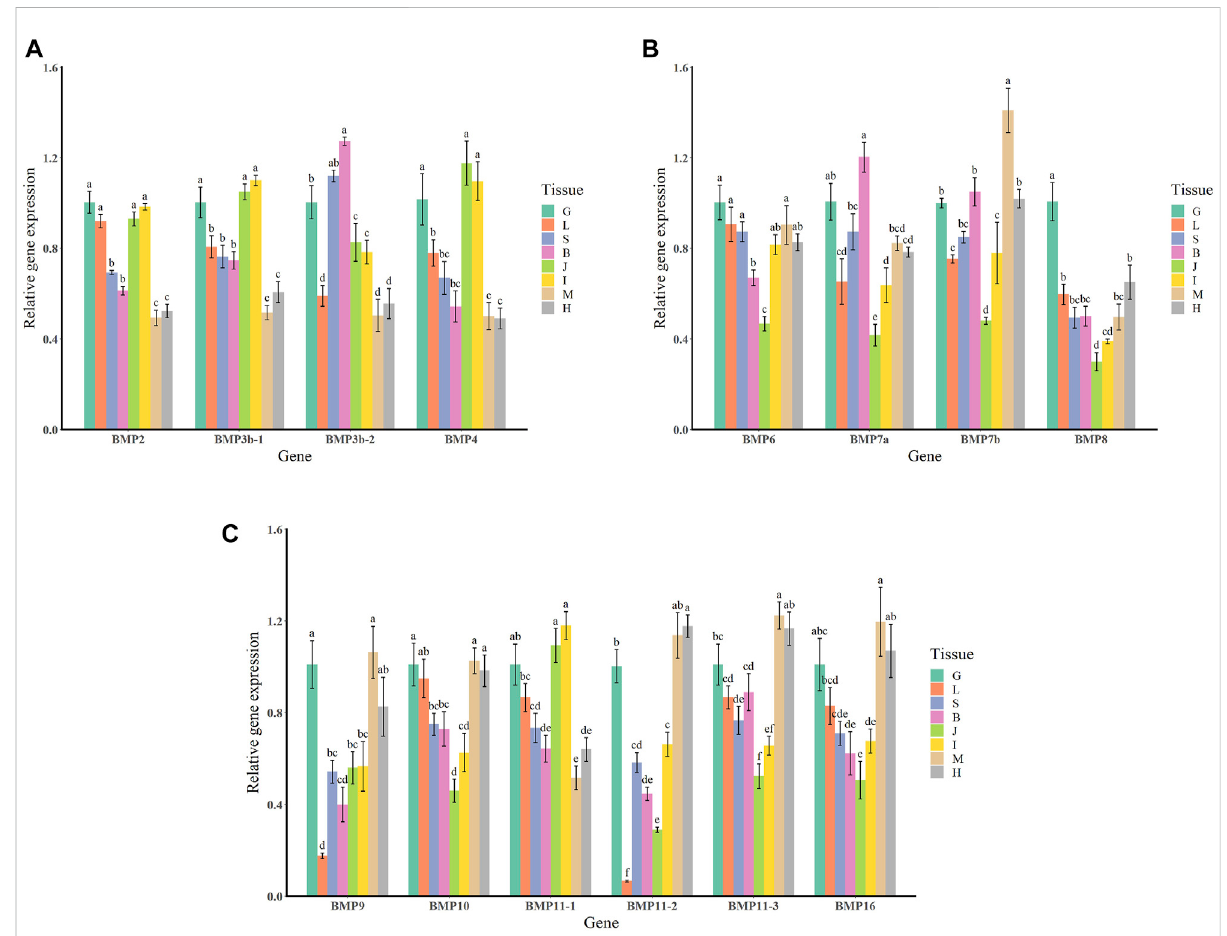
FIGURE 8 Relative expressionlevels ofBMP genes inselected tissues of O. punctatus . (A) Shows thetissue-speci fi cexpression patternsof BMP2, BMP3b- 1, BMP3b-2 and BMP4; (B) shows the tissue-speci fi c expression patterns of BMP6, BMP7a, BMP7b and BMP8; (C) shows the tissue-speci fi c expression patterns of BMP9, BMP10, BMP11-1, BMP11-2, BMP11-3 and BMP16. G represents the gills; L represents the liver; S represents the spleen; B represents the brain; J represents the surrounding tissue of the beak-like teeth; I represents the intestine; M represents the muscle; H represents the heart. Different lowercase letters above the standard error bars indicate signi fi cant differences in